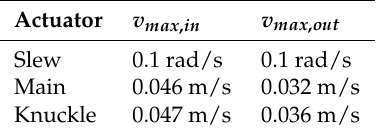
Table 2. Maximum velocities for the three